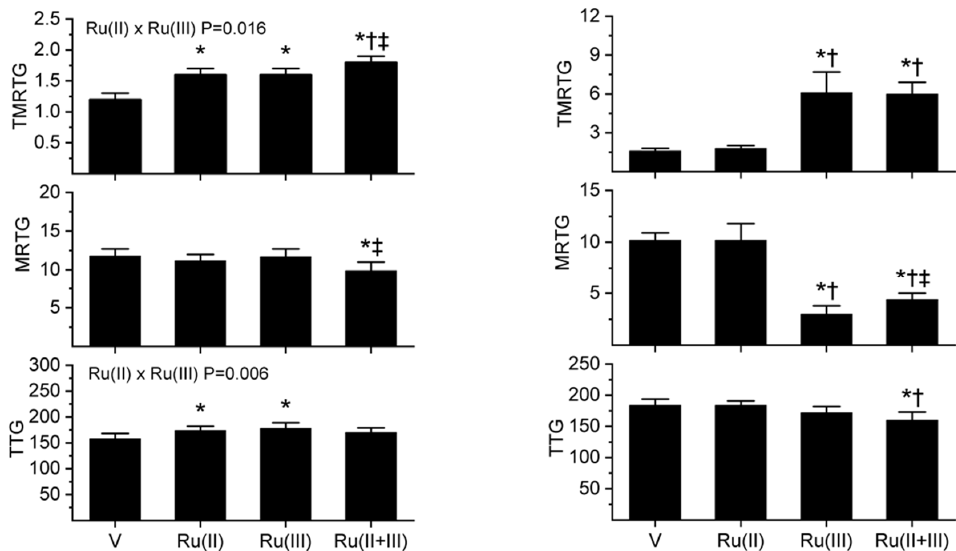
Figure 4. Procoagulant activity of B. moojeni venom (left panels) and C. rhodostoma venom (right panels) in plasma after exposure to CORM-3 (Ru(II)), RuCl 3 (Ru(III)) or both (Ru(II + III)) in isolation. Data is presented as mean ± SD. V = venom; Ru(II) = V + CORM-3 in PBS; Ru(III) = V + RuCl 3 ; Ru(II + III) = V + CORM-3 and RuCl 3 . * p < 0.05 vs. V; † p < 0.05 vs. Ru(II); ‡ p < 0.05 vs. Ru(III). Significant interactions between CORM-3 and RuCl 3 (Ru(II) × Ru(III)) determined with two-way ANOVA are displayed within individual parameter graphics.